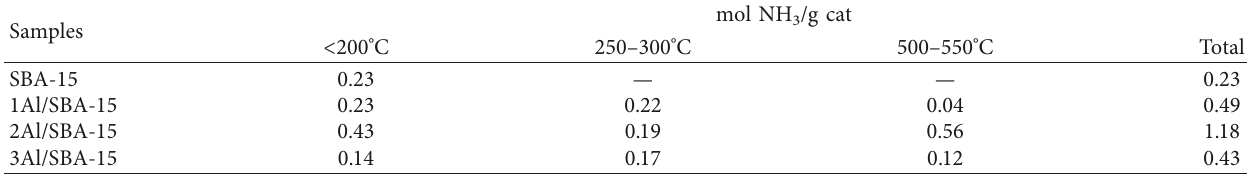
Table 4: NH 3 amount of weak, medium, and strong acid sites of SBA-15 and xAl/SBA-15.